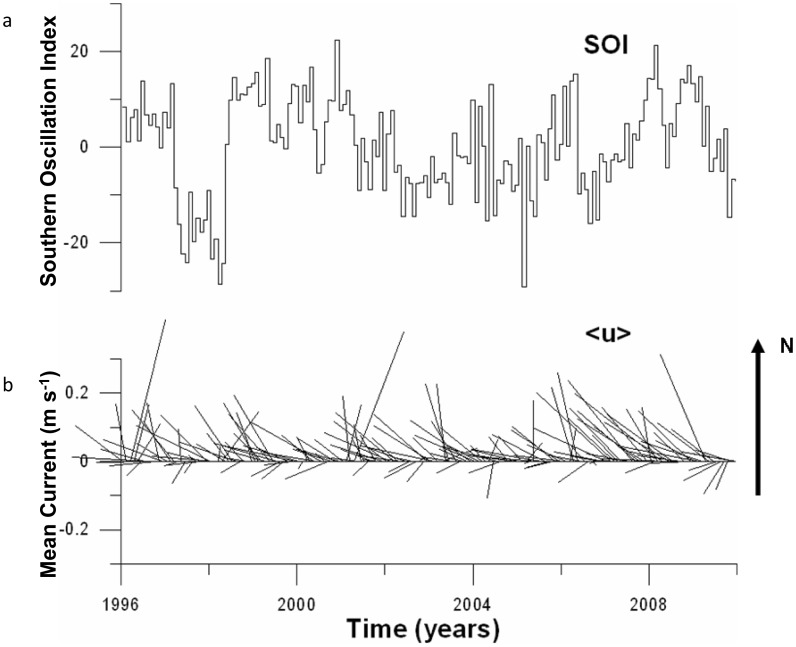
(a) Time-series stick plot of the Southern Oscillation Index (SOI) and (b) the altimetry-derived, near surface, monthly averaged currents <u>, indicating direction and magnitude (length of vectors) in the waters off the Palau archipelago.